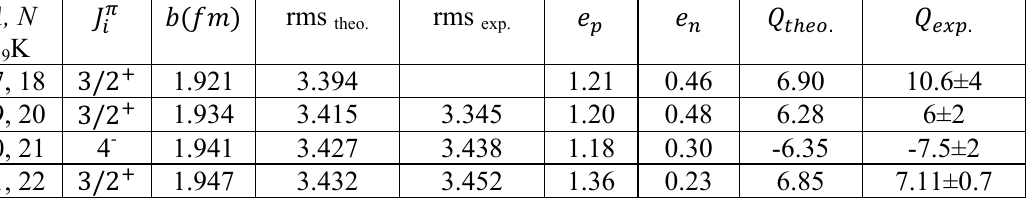
Table 7: Quadrupole moments in units of (cid:2187) (cid:2188)(cid:2195) (cid:2779) calculated with harmonic oscillator (HO) potential for Potassium (K) isotopes (Z = 19). Effective proton and neutron charges are deduced from the core polarization calculation. Experimental quadrupole moments are taken from Ref. [18].